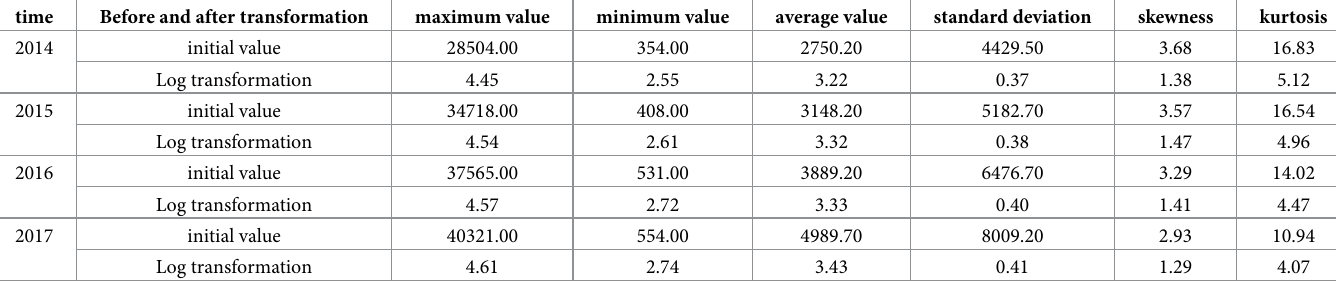
Table 3. Statistics of sample characteristics of residential land prices in Beijing-Tianjin-Hebei